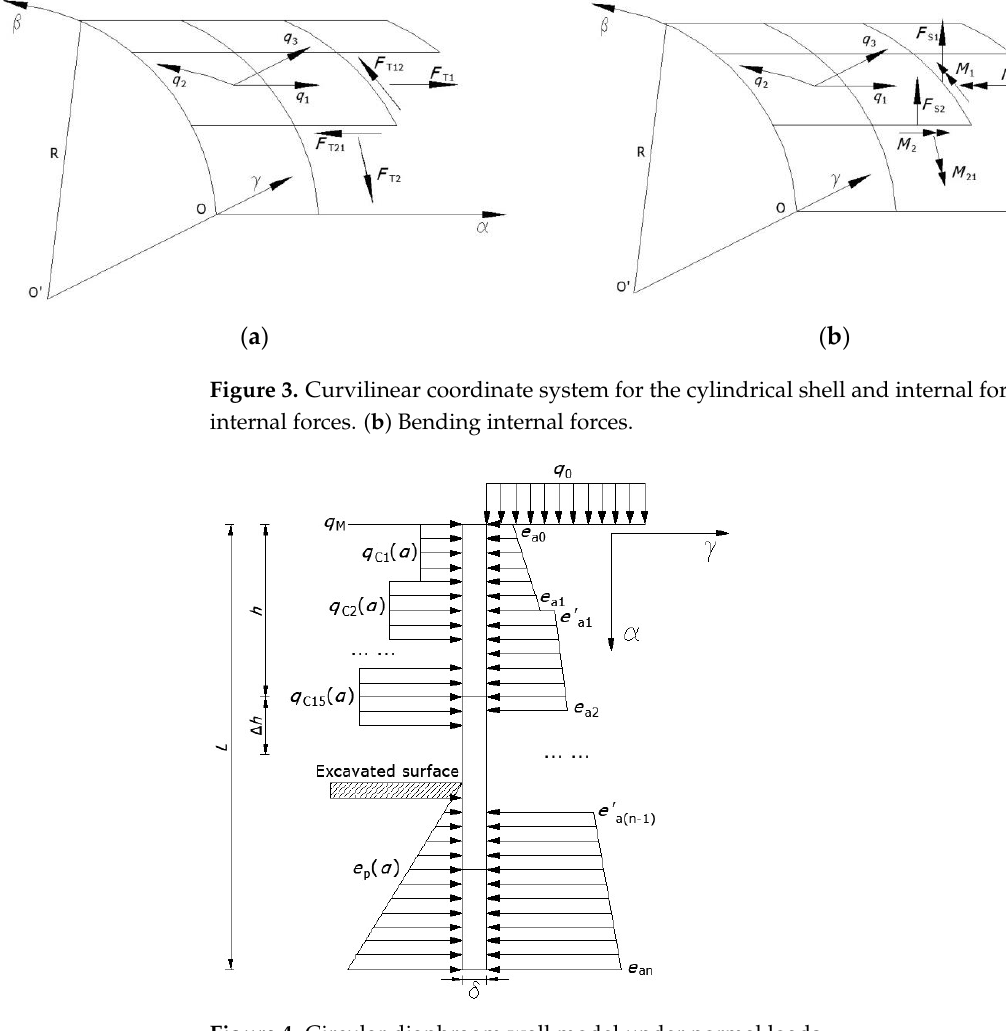
Figure 4. Circular diaphragm wall model under normal loads.